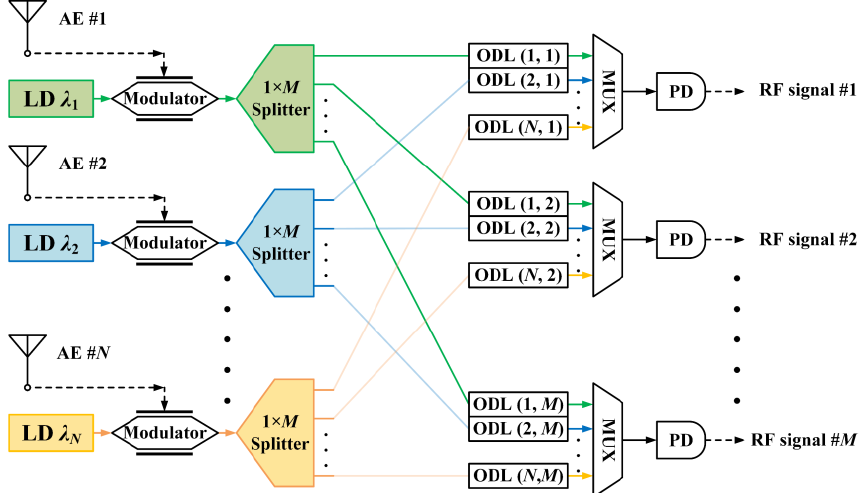
Figure 1. Illustration of the conventional multi-beam receiver. LD: laser diode; ODL: optical delay line; MUX: multiplexer; PD: photoelectric detector.